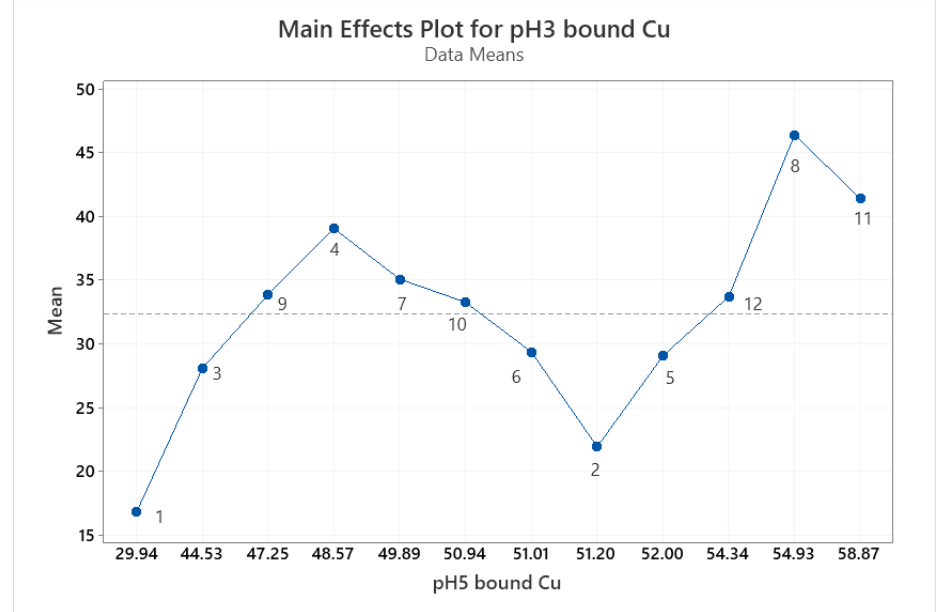
Figure 6. Main effects plot for bound Cu at pH 3 vs. pH 5. The values 1 – 12 represent the average value obtained from results obtained at pH 3 and pH 5 for the 12 individual hydrolysates in Table 1.